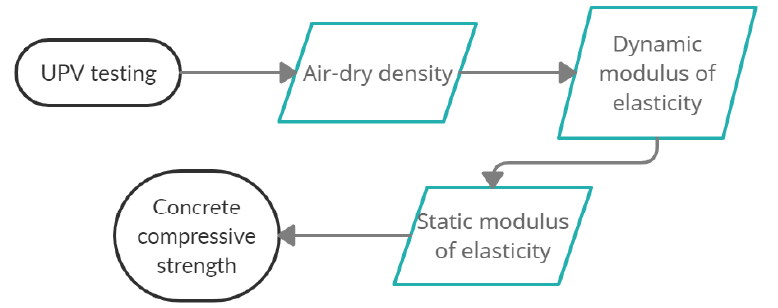
Figure 3. Flowchart of the presented method.